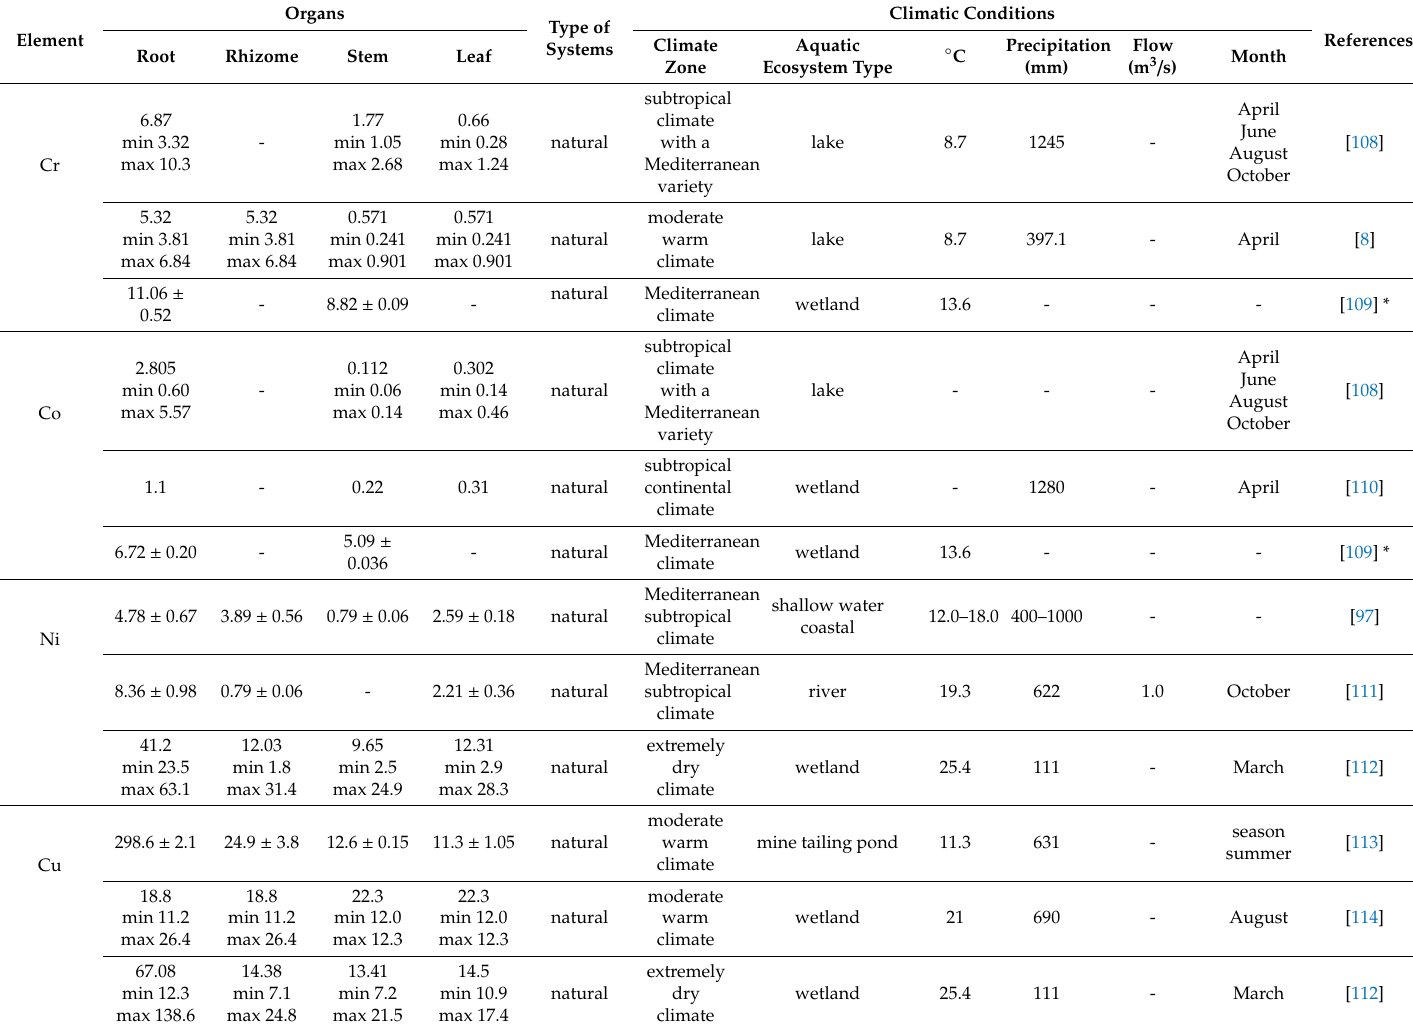
Table 2. Heavy metal concentrations in the organs of P. australis (mg / kg, standard deviation SD). Organs